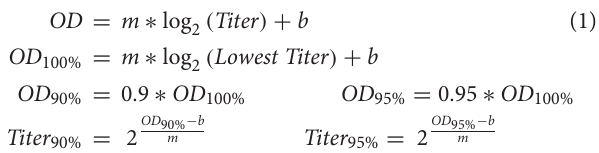
TABLE 1 | Linear regression fit of the NA activity of the viruses tested in the panel. Strain PFU/ml Fitted equation R 2 100% 95% 90%